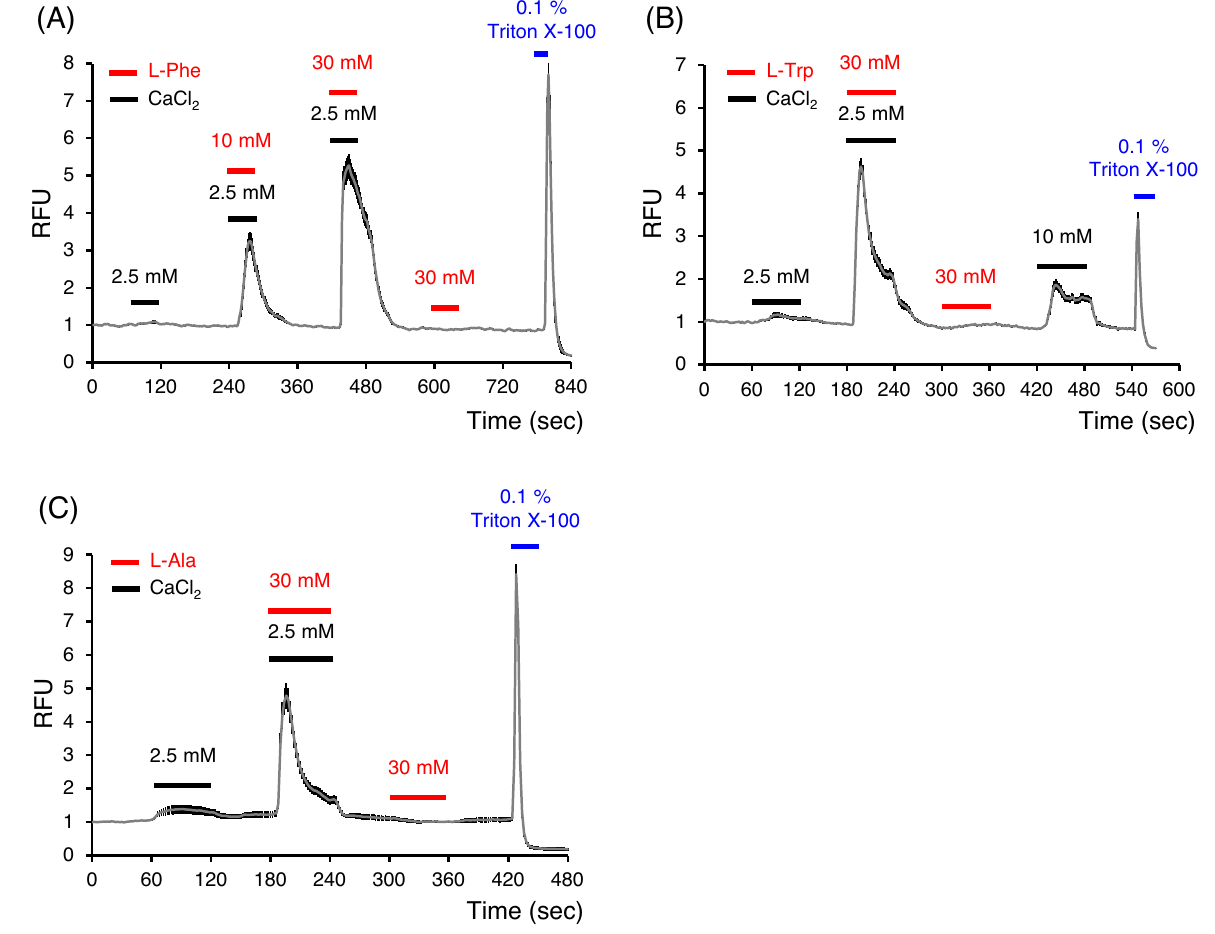
Figure 4. L-Phe, L-Trp, and L-Ala enhanced cCaSR activities with 2.5 mM CaCl 2 . ( A ) L-Phe enhanced cCaSR activity with 2.5 mM CaCl 2 in a dose dependent manner. ( B ) Thirty mM L-Trp enhanced cCaSR activity with 2.5 mM CaCl 2 . ( C ) Thirty mM L-Ala also enhanced cCaSR activity with 2.5 mM CaCl 2 . RFU: relative fluorescence units, the index of cytosolic Ca 2+ concentration. Data are means ± SE (n = 70–100